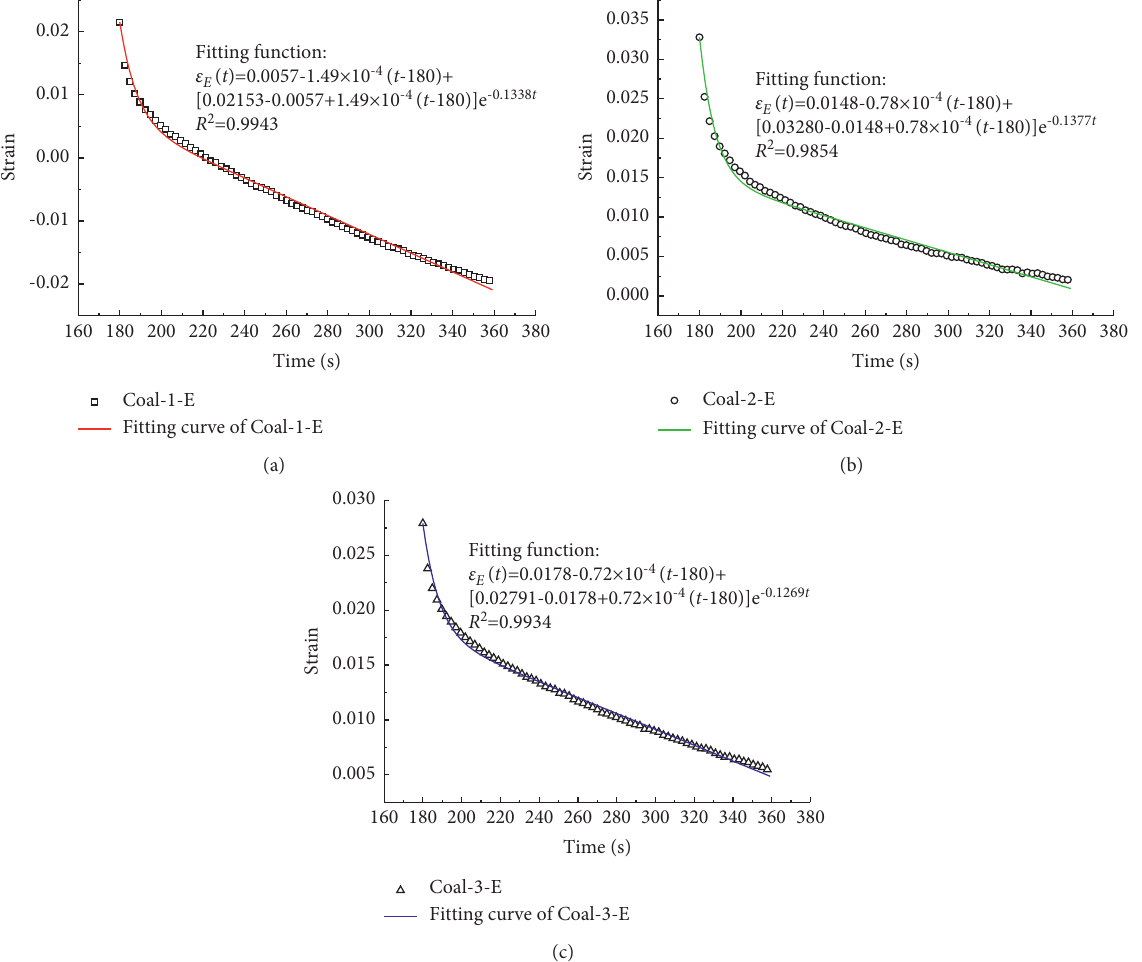
Figure 8: Fitting results of elastic aftereffect curves of (a) coal-1, (b) coal-2, and (c) coal-3 by using the elastic aftereffect equation of the simplified Burgers